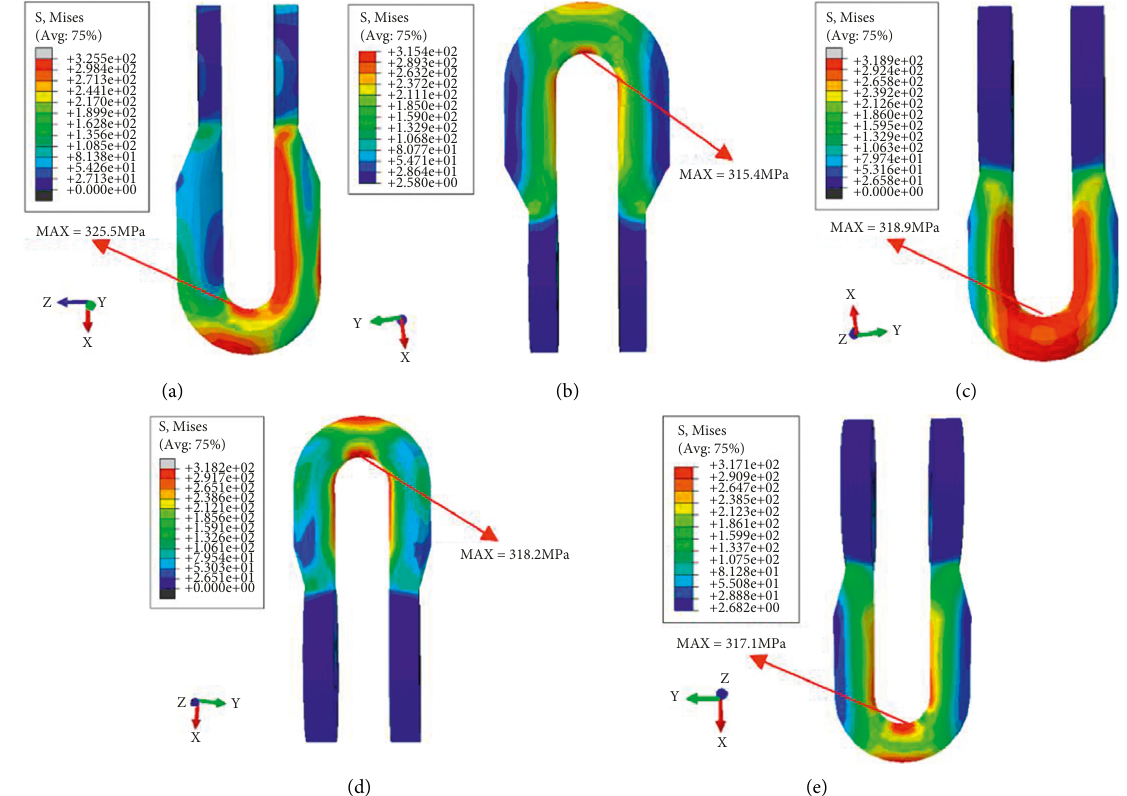
Figure 30: Stress cloud picture at maximum stress time for each shackle. (a) Shackle 1/part-(1), (b) Shackle 2/part-(2), (c) Upper shackle 3/ part-(15), (d) Lower shackle 3/part-(16), (e) Shackle